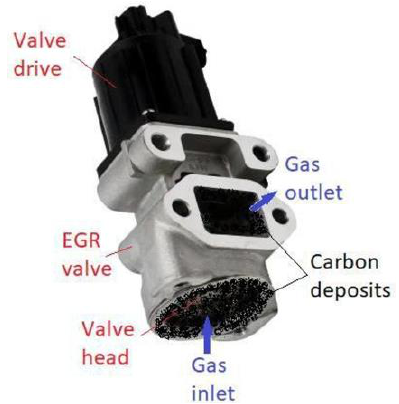
Fig. 1. EGR-valve covered with Carbon Deposits